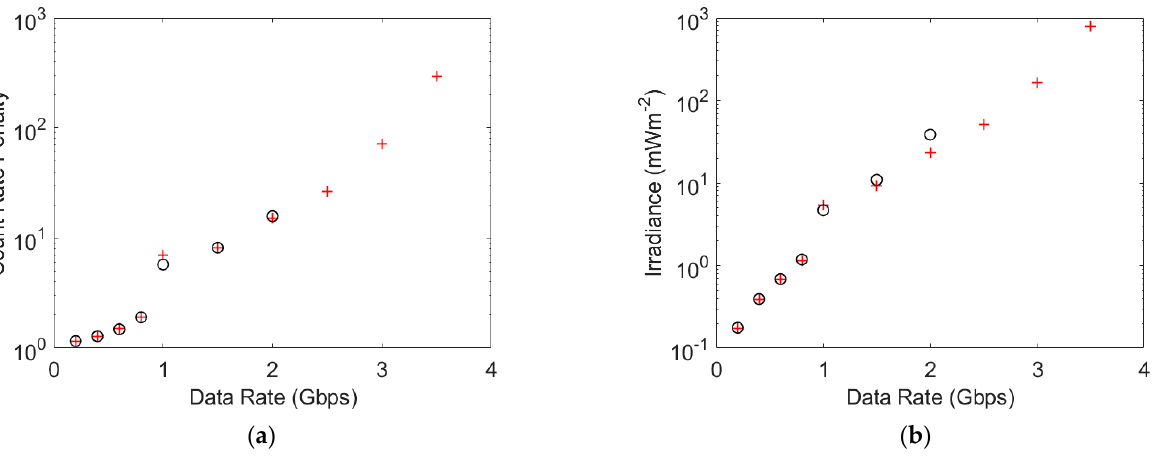
Figure 6. ( a ) The count rate penalty required to achieve a BER of 3.8 × 10 − 3 at data rates that are high enough for the fast output pulses to create ISI. The parameters for a J30020 were used to obtain the simulation results shown in black circles (o). The simulation results shown as red crosses (+) were obtained assuming that a J30020 SiPM had a recharge time of 1 ps, and therefore had a linear response. The irradiance needed by a J30020 to support these count rate penalties is shown in ( b ).